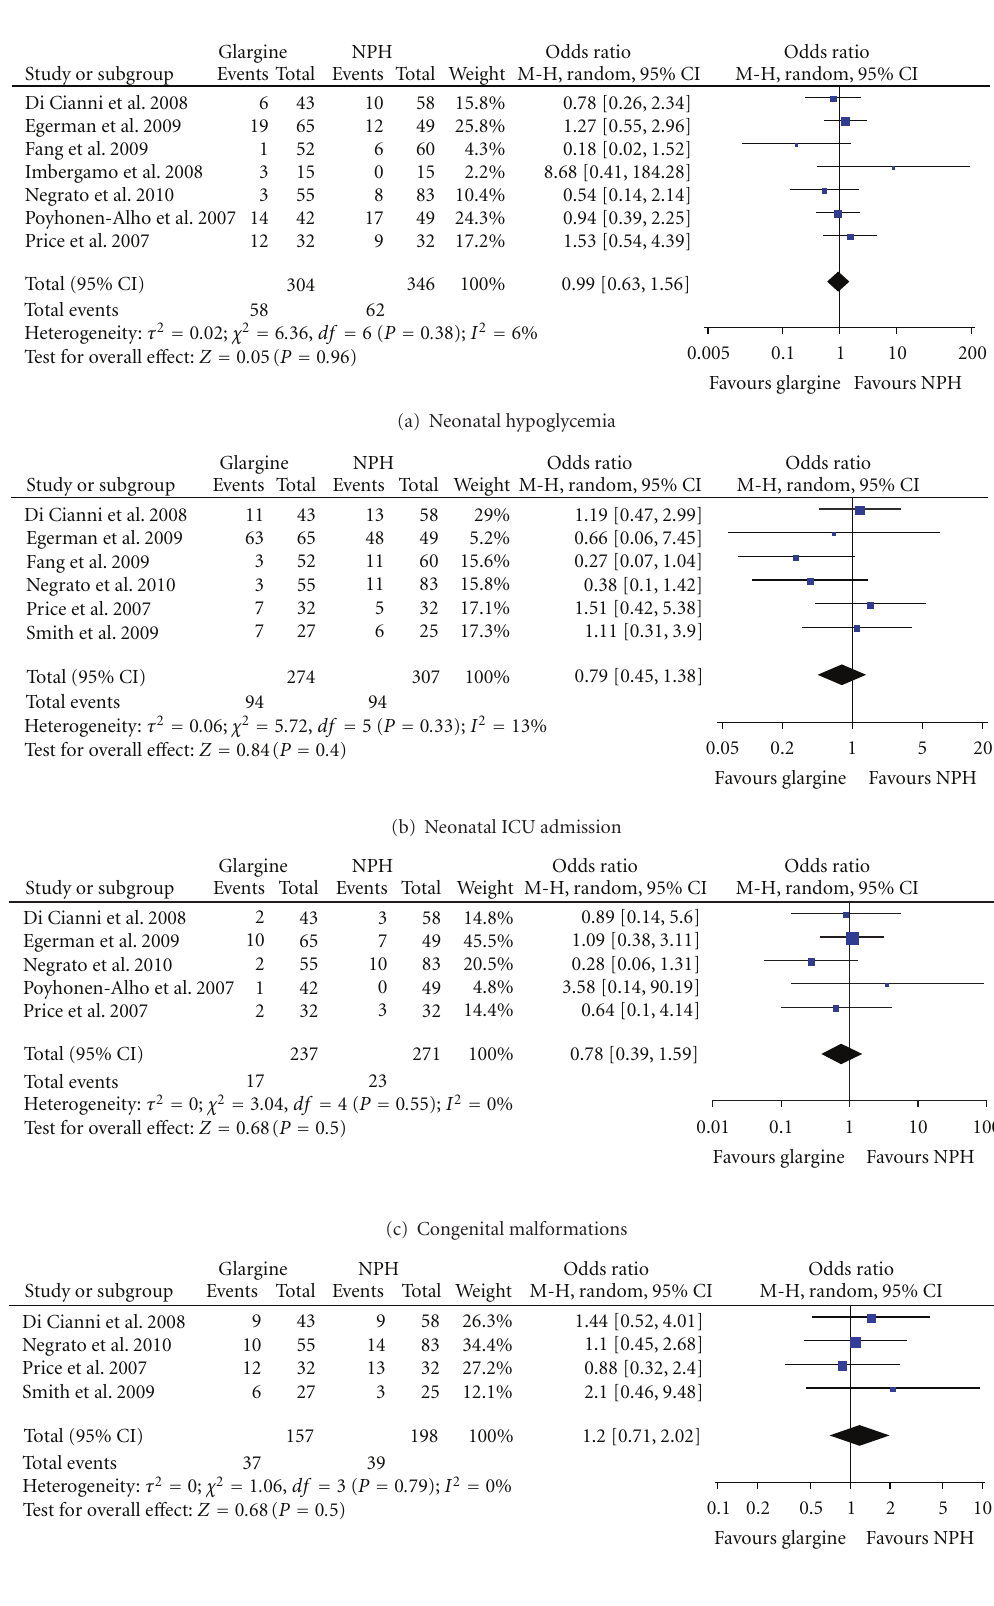
Figure 3: Meta-analysis results for neonatal